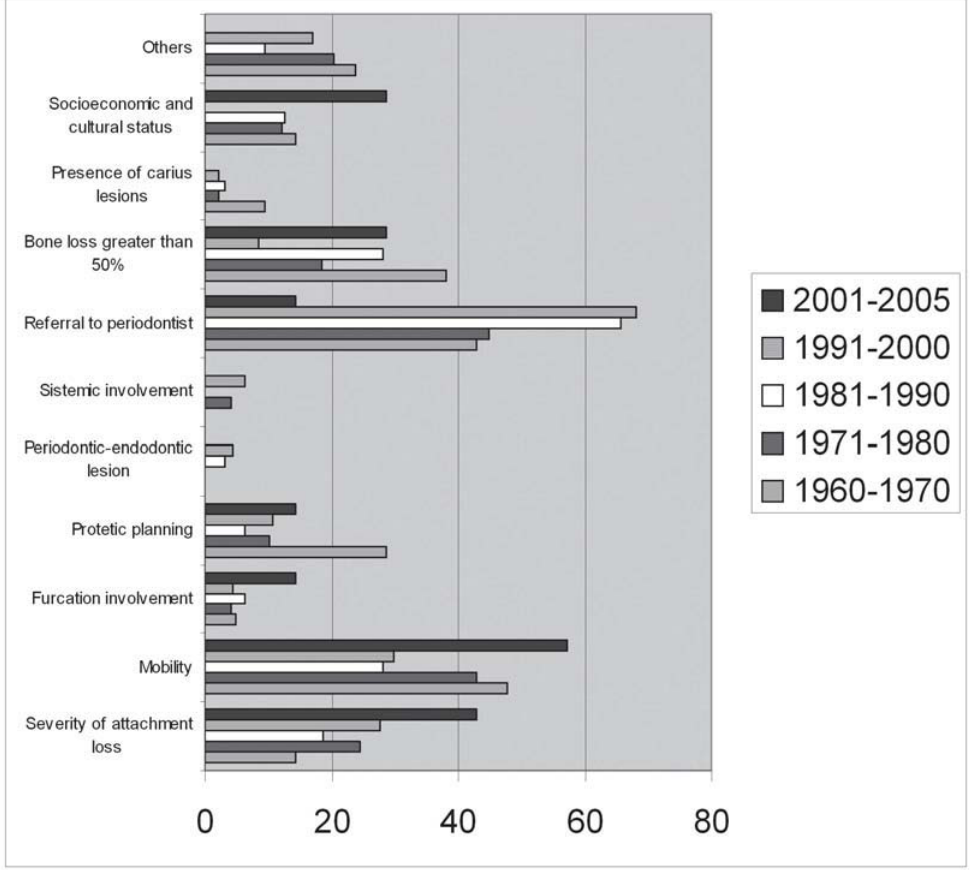
FIGURE 1- Criteria adopted by the dentists to indicate the extraction of teeth with periodontitis (%), stratified according to year of